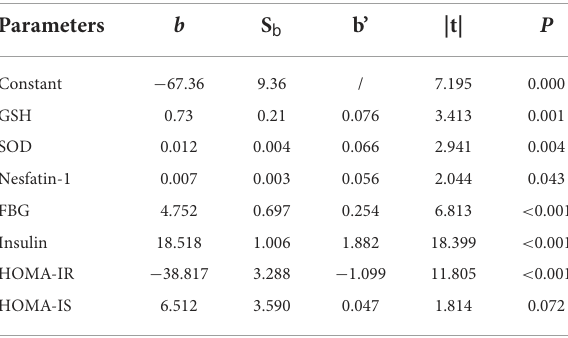
TABLE 2 Independent variables introduced to multiple liner